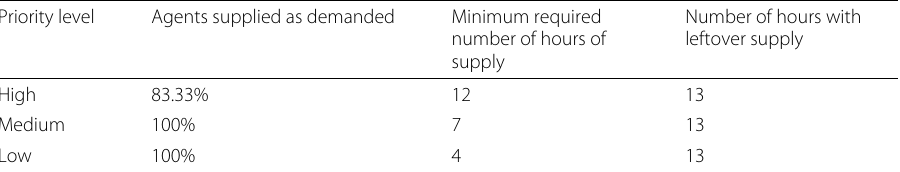
when supply starts rising and declining, respectively, and demand fluctuates significantly.